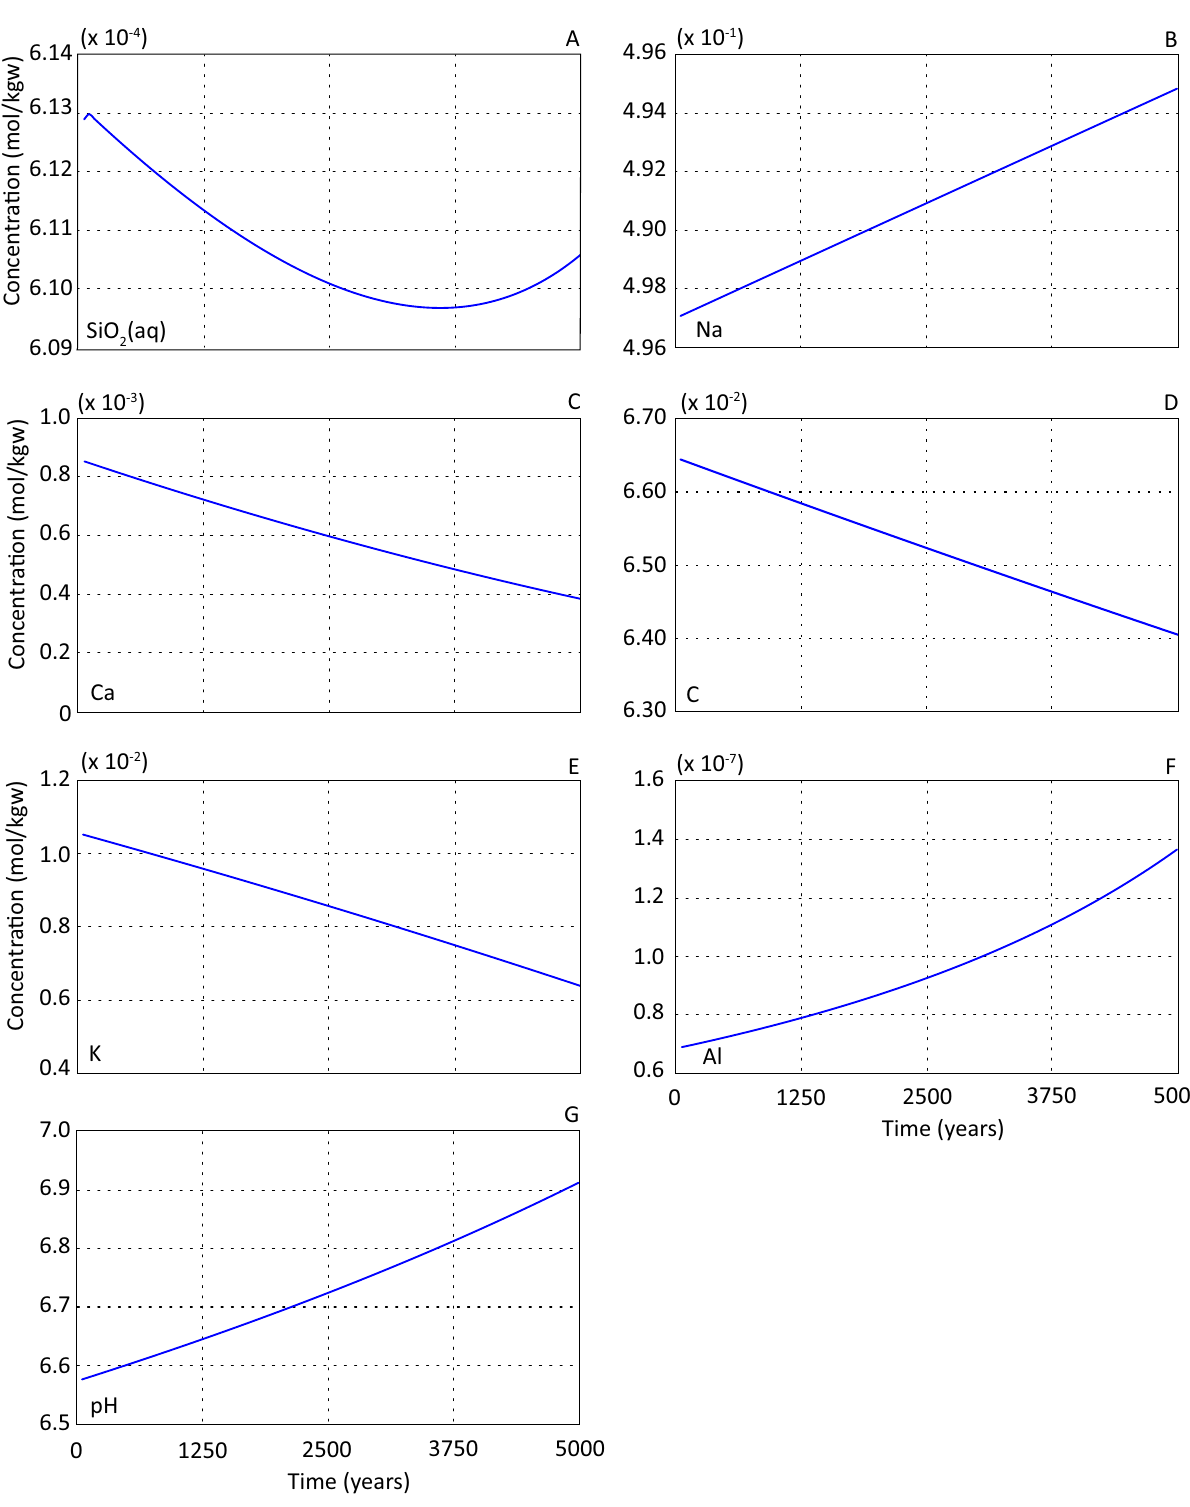
Figure 3. Element concentration (mol/kg water) and pH presented for cell #31 over the simulated period for scenario